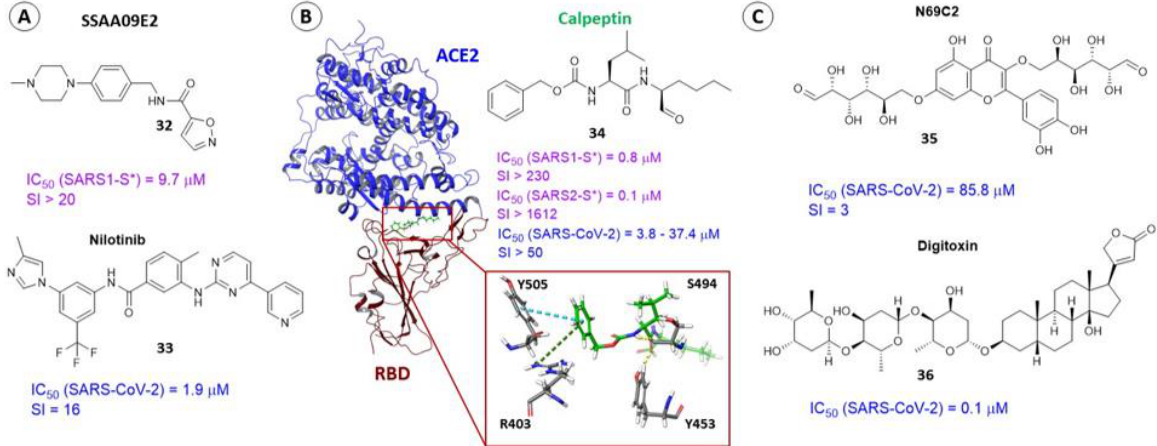
Figure 12. Inhibitors of S 1 SARS-CoV-2. Molecular structures ( A – C ). The location of calpeptin ( B ) in the RBD – ACE2 interface: hydrogen bonds are shown by yellow dotted lines, π–π and π– cation stacking interactions are indicated by blue and green dotted lines, respectively. *-Pseudotype- based